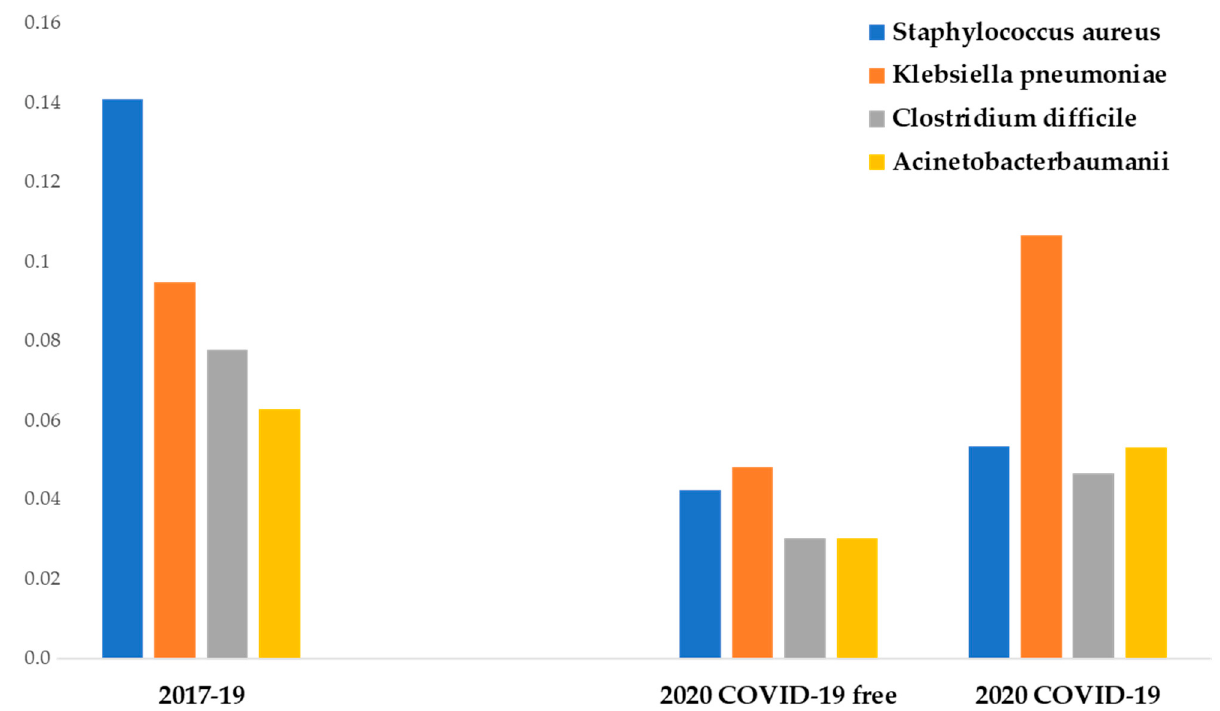
Figure 2. Data from medical departments between 1 March and 30 June. The ordinate axis represents the infection incidence of MDR bacteria. The abscissas axis represents time.